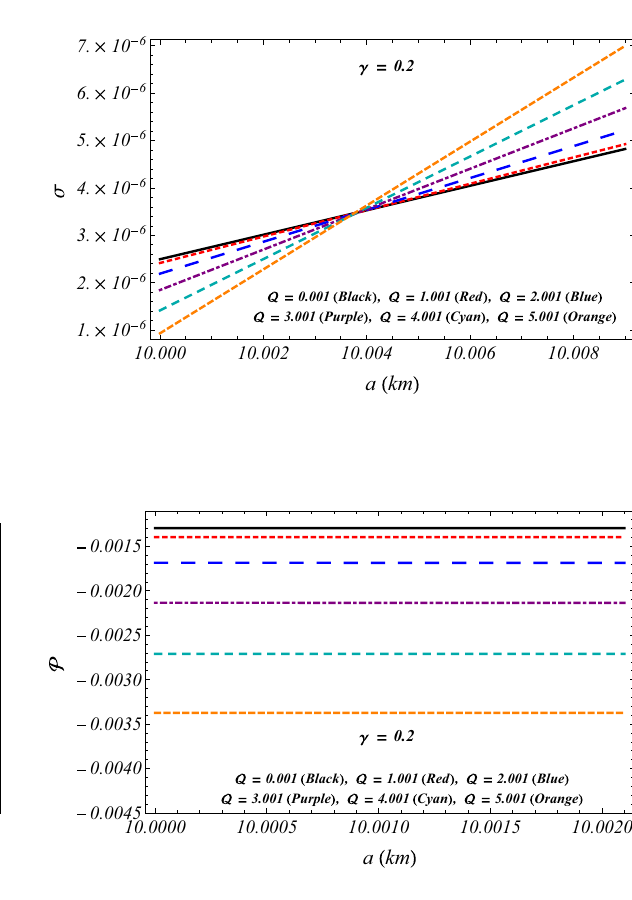
Fig. 5 Variation of surface pressure inside the thin